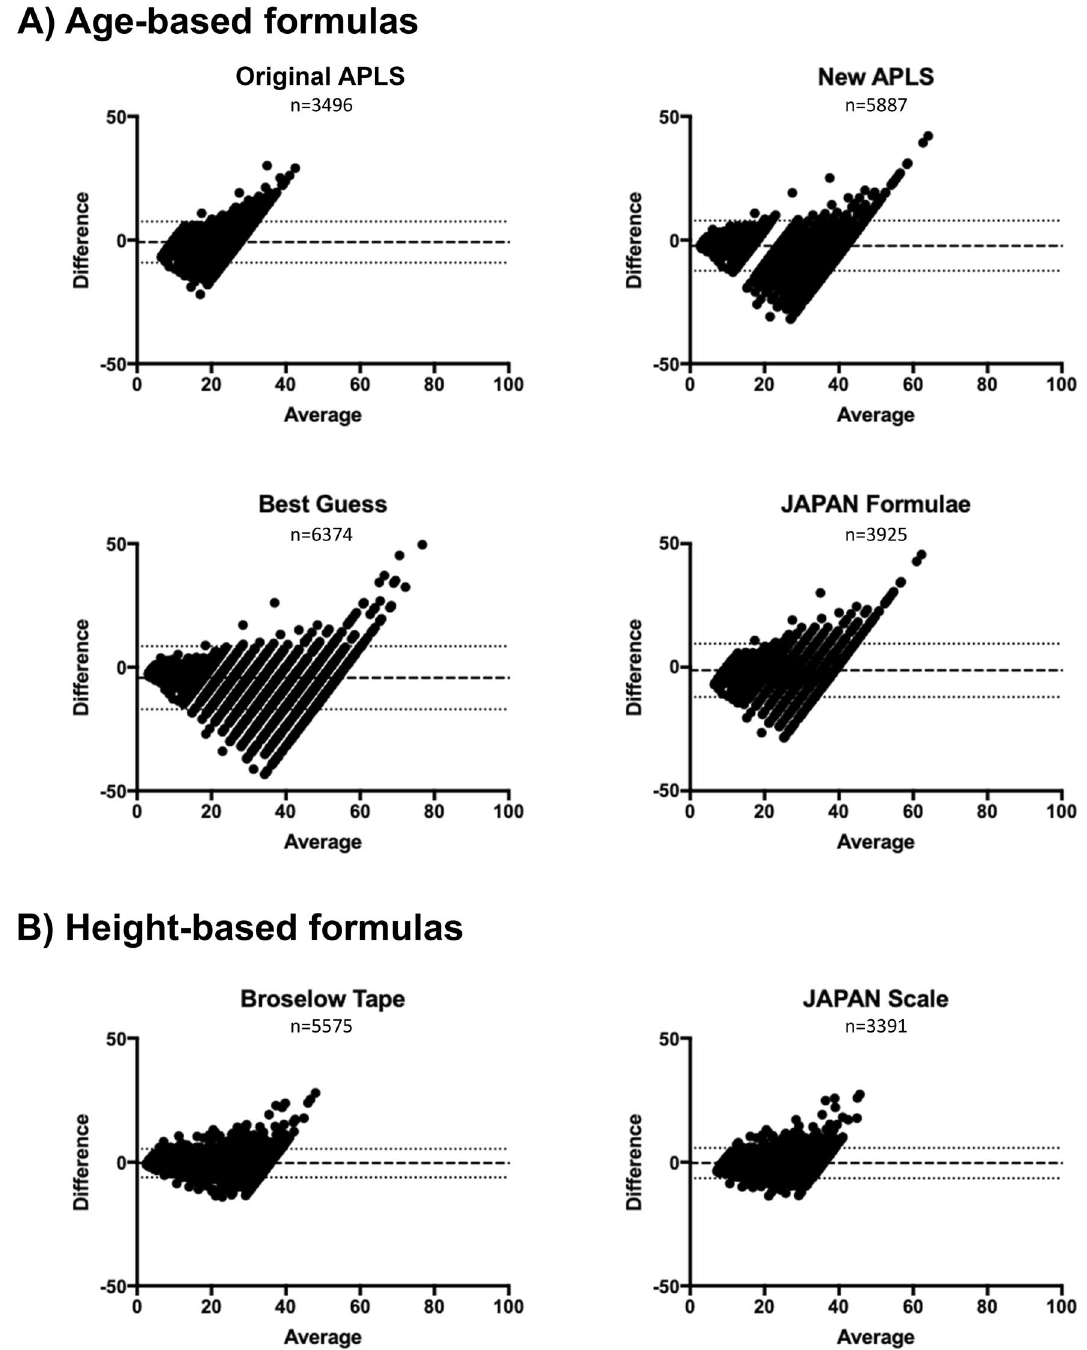
Figure 3. Bland–Altman plots for estimated bodyweight and measured bodyweight. Bland–Altman plots were drawn for 4 age-based formulas ( A ) and 2 height-based formulas ( B ). For the Bland–Altman plots, the long- dashed line indicates the bias, and the area between the short-dashed lines denotes the 95% limits of agreement. There is one data point plotted outside the axis limit in New APLS, Best Guess, JAPAN Formulae, and Broselow Tape,